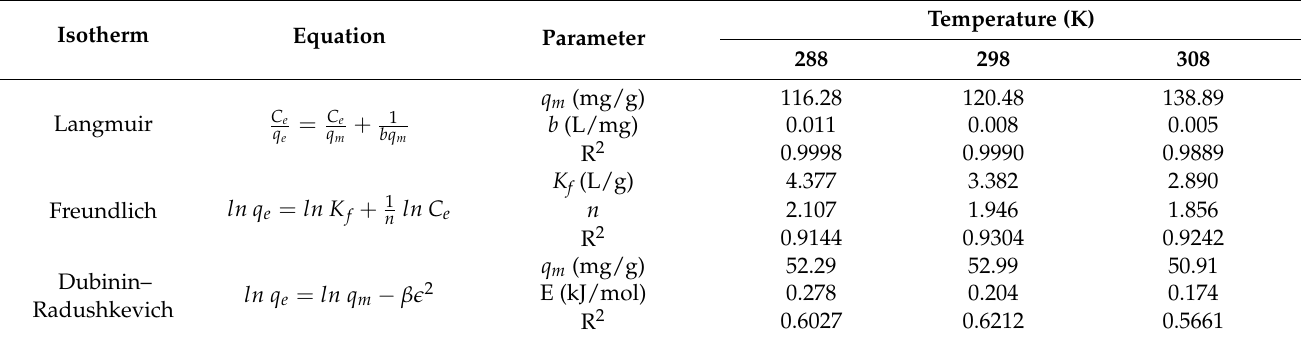
Table 3. Isotherm parameters for the adsorption of enrofloxacin onto P. koidzumii